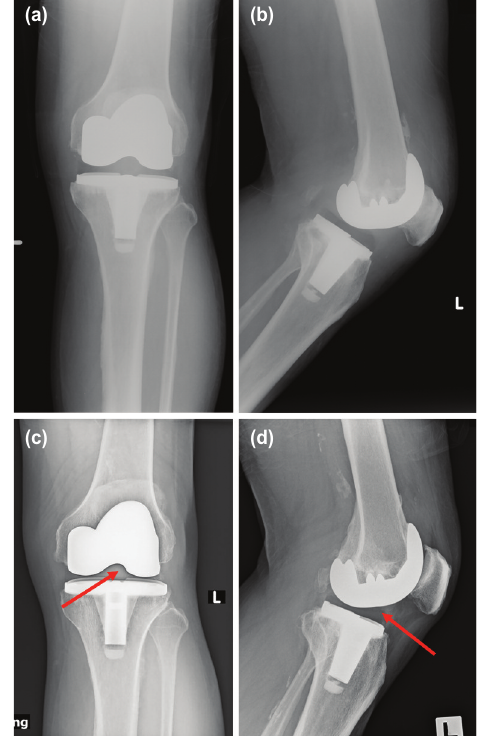
Plain radiographs of the total knee arthroplasty (TKA) at Fig. 1: various time points. (a) Anteroposterior (AP) view after the index surgery. (b) Lateral view after the index surgery. (c) AP view on presentation. Arrow denotes the likely position of the tibial post of the polyethylene (PE) insert. (d) Lateral view on presentation. Arrow denotes the likely position of the tibial post of the PE insert.